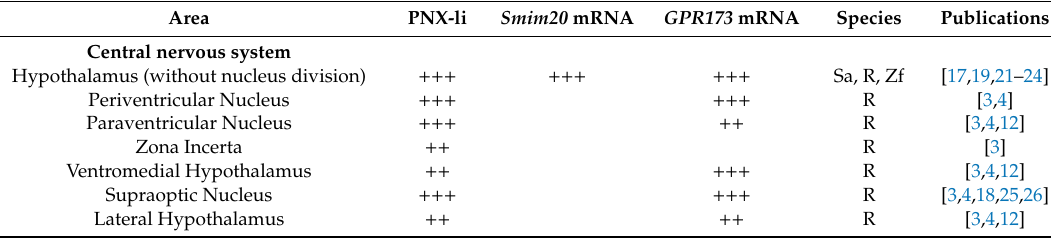
Table 1. The semi-quantitative estimation of phoenixin-like immunoreactivity (PNX-li) and Smim20 and GPR173 mRNA expression in rat (R), mouse (M), human (H), pig (P), zebrafish (Zf), Scatophagus argus (Sa). −, no expression; +, low expression level; ++, medium expression level; +++, high expression level.